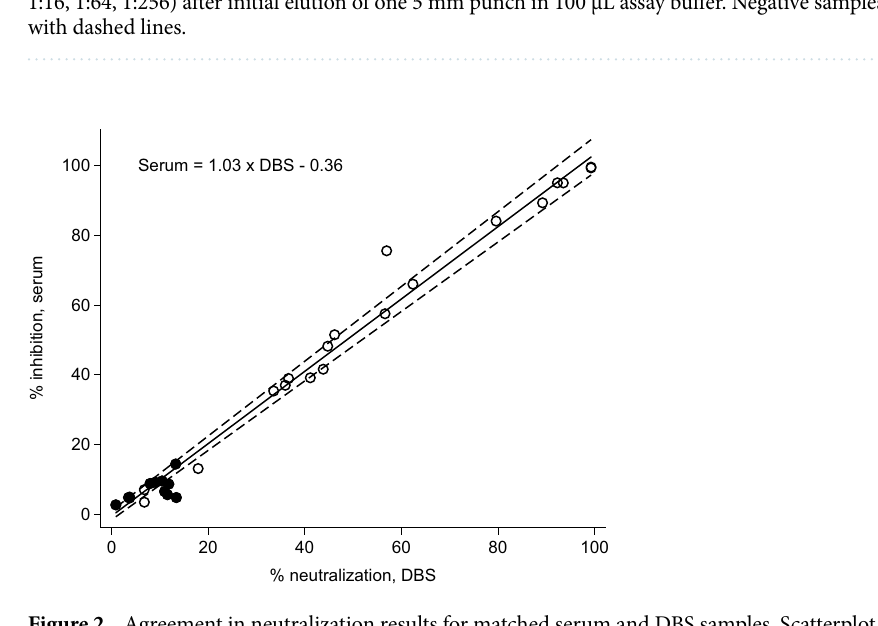
Figure 2. Agreement in neutralization results for matched serum and DBS samples. Scatterplot and Passing- Bablok regression line (95% CI) demonstrating agreement in % neutralization of SARS-CoV-2 Spike-ACE2 interaction in DBS and serum samples. PCR positive samples are indicated with open circles; negative samples are indicated with black circles. The concordance correlation of absolute agreement =